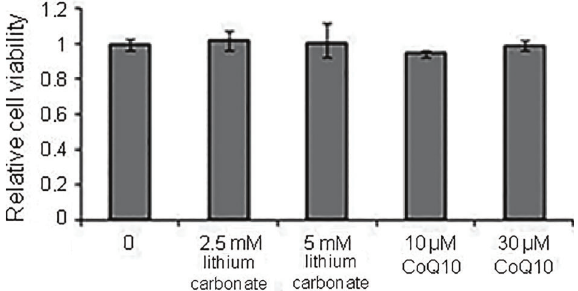
Figure 1. PC12 cells transfected with full-length normal ATX3 (Q28) and treated with different concentrations of lithium